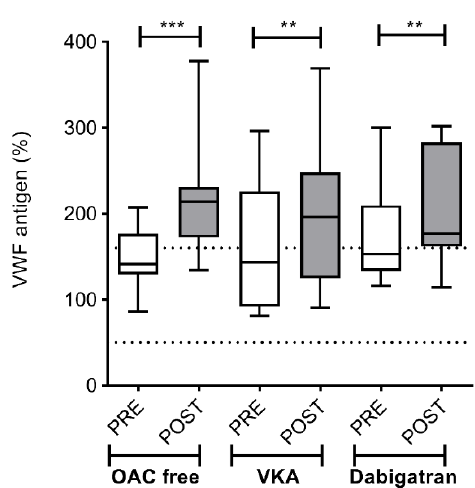
Figure 7. Left atrium von Willebrand factor (VWF) antigen levels before and after cryoballoon ablation procedure in AF patients on various pre-procedural anticoagulation strategies. Box and whisker plots indicate median, interquartile range, and total range. Dashed lines indicate lower and upper limit of reference interval (50–160%). PRE (empty bars): pre-ablation, POST (solid bars): post-ablation, OAC: oral anticoagulant, VKA: vitamin K antagonist. ** p < 0.01, *** p < 0.001.